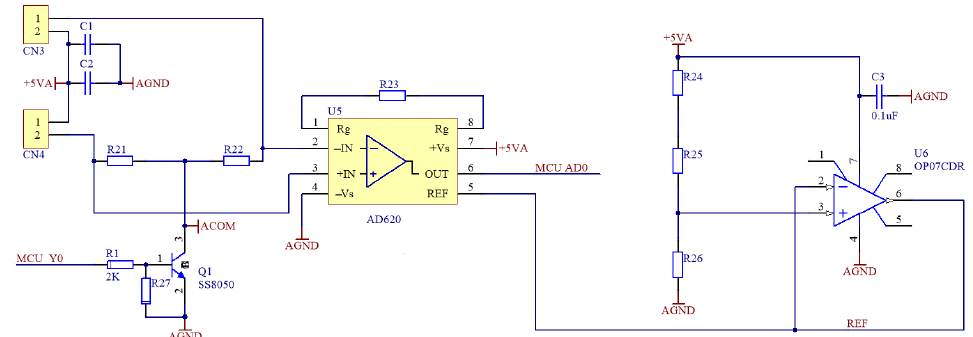
Figure 2. Measurement signal amplification circuit diagram.